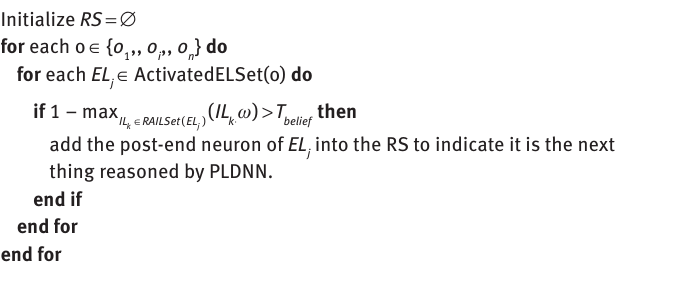
Algorithm 1: Associating of